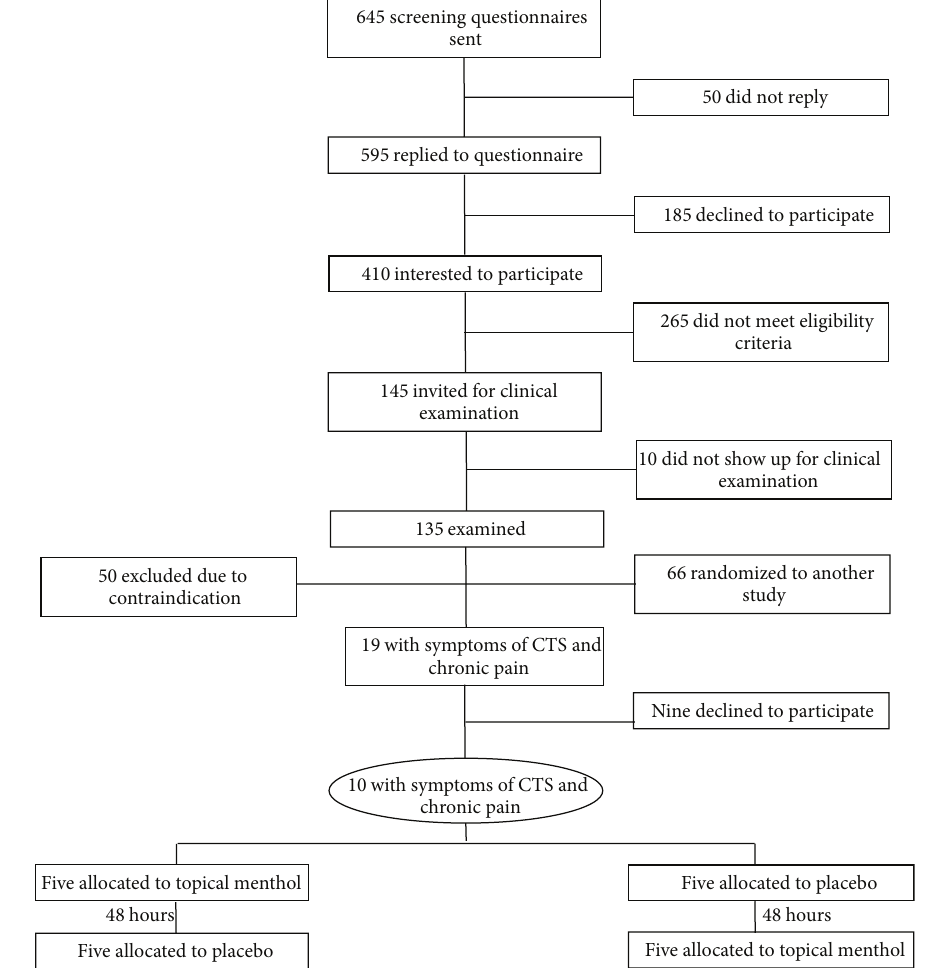
Figure 1: Participants flow. CTS denotes carpal tunnel